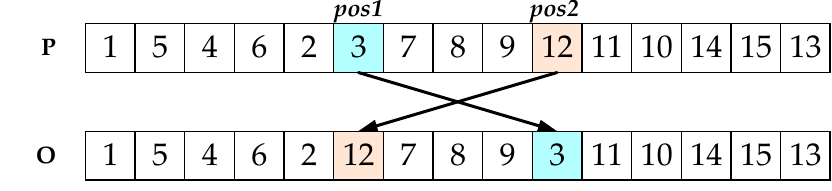
Figure 10. An example of mutation for operation layer.